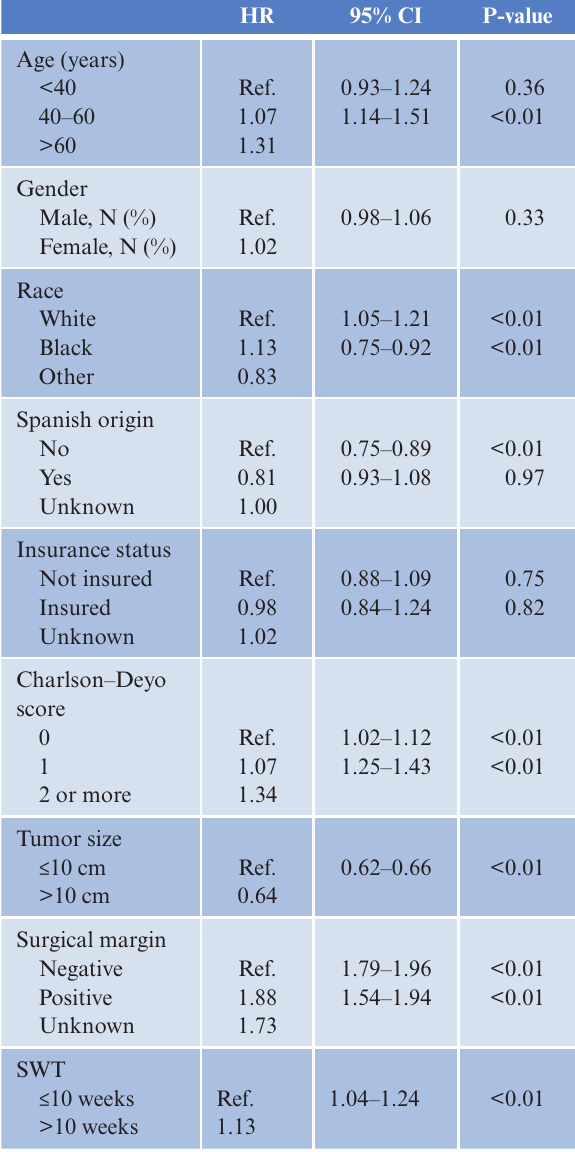
Table 4: Multivariate cox regression for 5-year overall